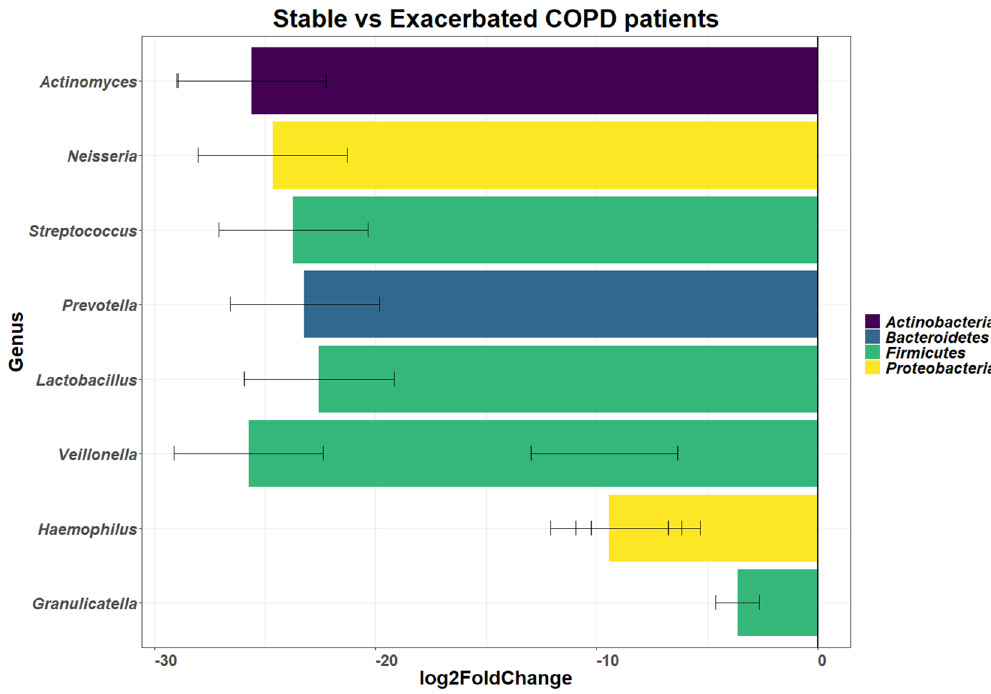
Figure 2. Graph of the DESeq2 analysis showing the log2fold differential abundance of the different genera between the exacerbated state and stable state of disease (n = 24) in the sputum microbiome of COPD participants. Differences were considered significant with the p-value (adjusted for false discovery rate using Benjamini–Hochberg correction) cut-off of 0.2. Log2fold changes greater than zero indicated an increase in the relevant genera, whereas log2fold changes less than zero indicated a decrease in the relevant genera. All genera shown below the zero line had a decreased relative abundance with the stable state of disease i.e. these genera were increased during the exacerbated state of disease. The error bars corresponding to the calculated lfcSE (standard